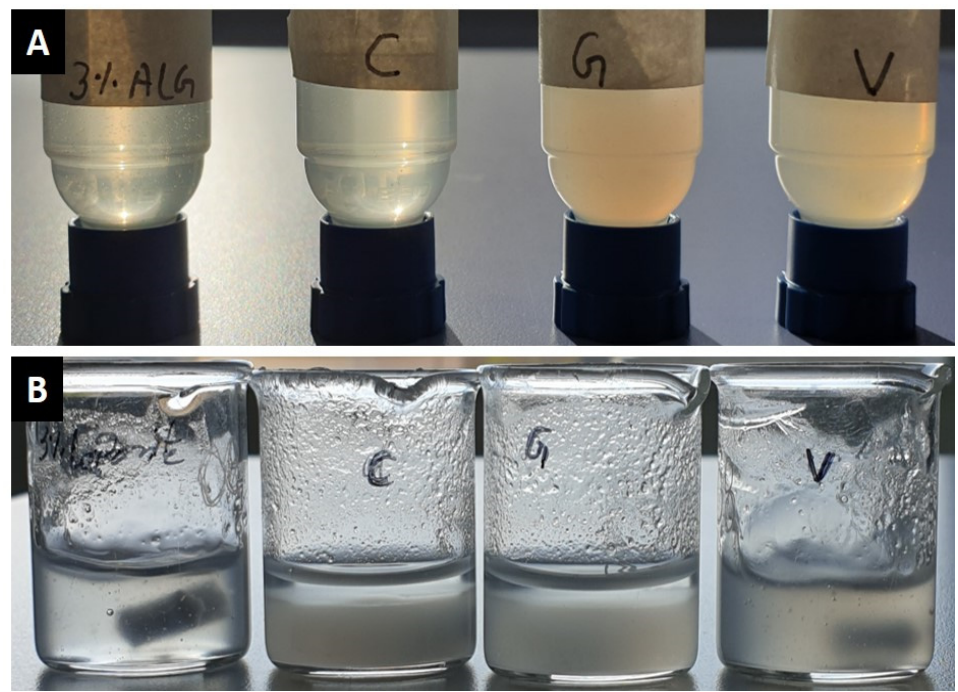
Figure 1. ( A ) Images of pure 3% alginate and of clindamycin, gentamicin, and vancomycin in 3% alginate at a concentration of 10 mg/mL (positioned left to right, respectively). ( B ) Images of pure 3% Laponite and of clindamycin, gentamicin, and vancomycin in 3% Laponite at a concentration of 10 mg/mL (positioned left to right, respectively). After adding 20 mg/mL antibiotic solution to 6% Laponite and stirring, a clear phase separation (after a few minutes at rest) of clindamycin and gentamicin was observed.